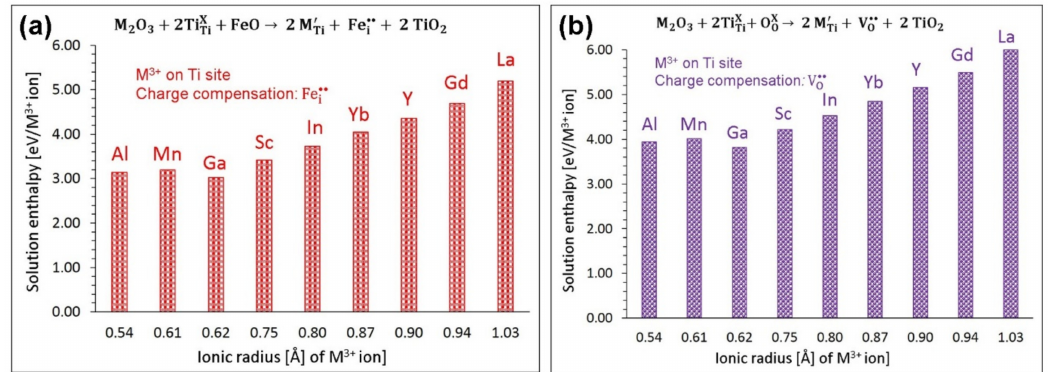
Figure 6. Solution enthalpies of M 2 O 3 with respect to the ionic radius of M 3 + at the Ti site forming ( a ) Fe interstitials and ( b ) O vacancies.